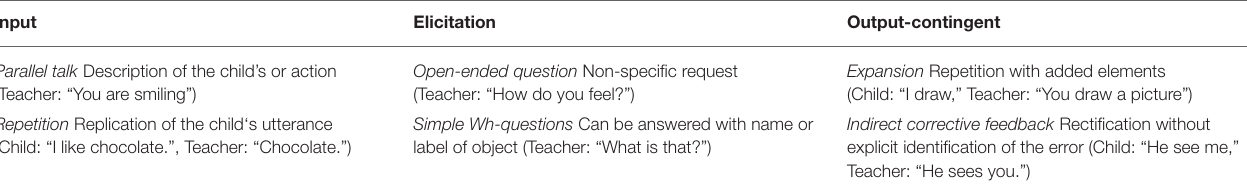
TABLE 1 | Examples of language support strategies.